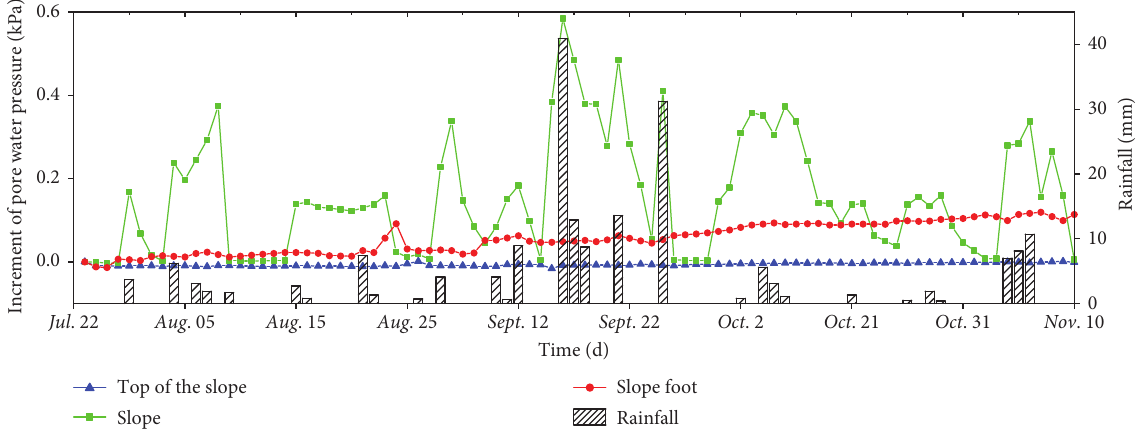
Figure 8: Time history curve of pore water pressure at different positions on the slope